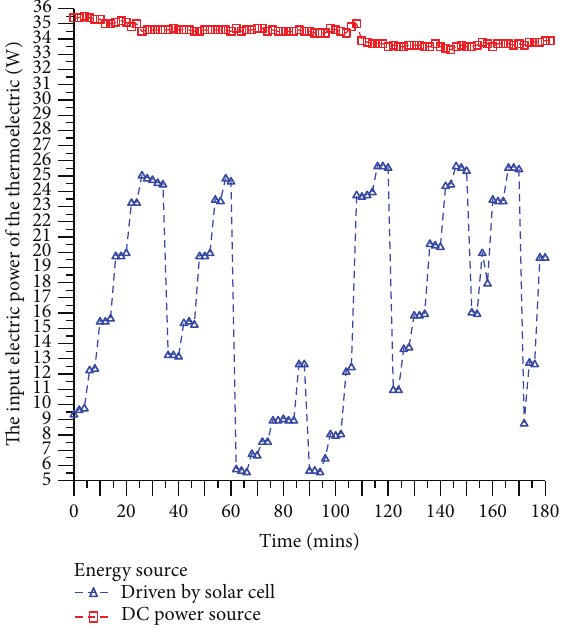
Figure 10: The input electric powers of the thermoelectric system by DC source and solar